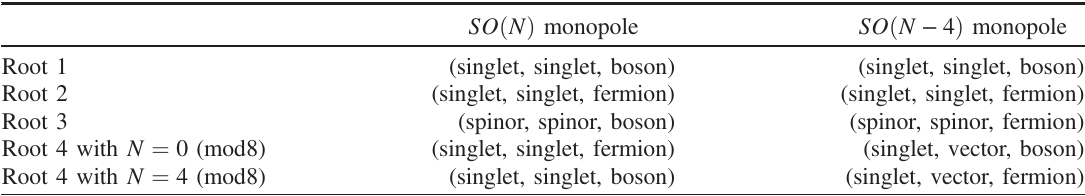
TABLE II. Properties of the SO ð N Þ and SO ð N − 4 Þ monopoles of the root states for even N . The first three roots apply to all even N , and root 4 only applies to the case with N an integral multiple of 4. The SO ð N Þ monopole breaks the I ð N Þ symmetry to ½ SO ð 2 Þ × SO ð N − 2 Þ × SO ð N − 4 Þ(cid:2) =Z 2 , and it always has no charge under the SO ð 2 Þ . Its three corresponding entries represent its representation under the SO ð N − 2 Þ , its representation under the SO ð N − 4 Þ , and its statistics, respectively. The SO ð N − 4 Þ monopole breaks the I ð N Þ symmetry to ½ SO ð N Þ × SO ð N − 6 Þ × SO ð 2 Þ(cid:2) =Z 2 , and it always has no charge under the SO ð 2 Þ . Its three corresponding entries represent its representation under the SO ð N Þ , its representation under the SO ð N − 6 Þ , and its statistics, respectively. For the case with N ¼ 6 , the second entry does not exist for its SO ð N − 4 Þ monopole. Note that these properties are determined up to attaching pure gauge